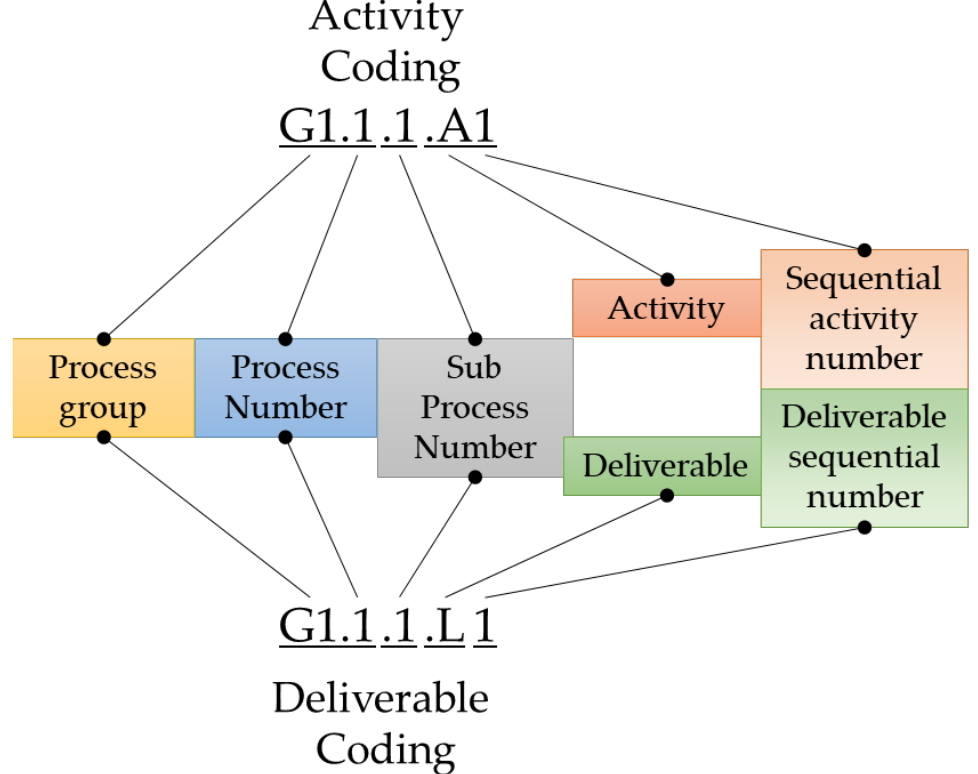
Figure 9. Activities and deliverables codification.